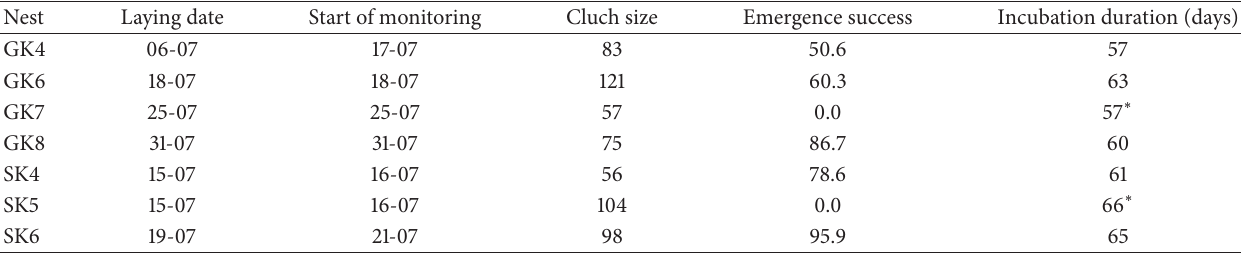
Table 1: Information on studied nests.